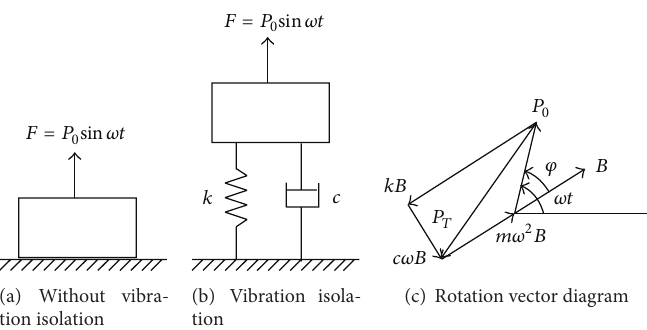
Figure 5: Force transmissibility of electromagnetic vibration exciter.